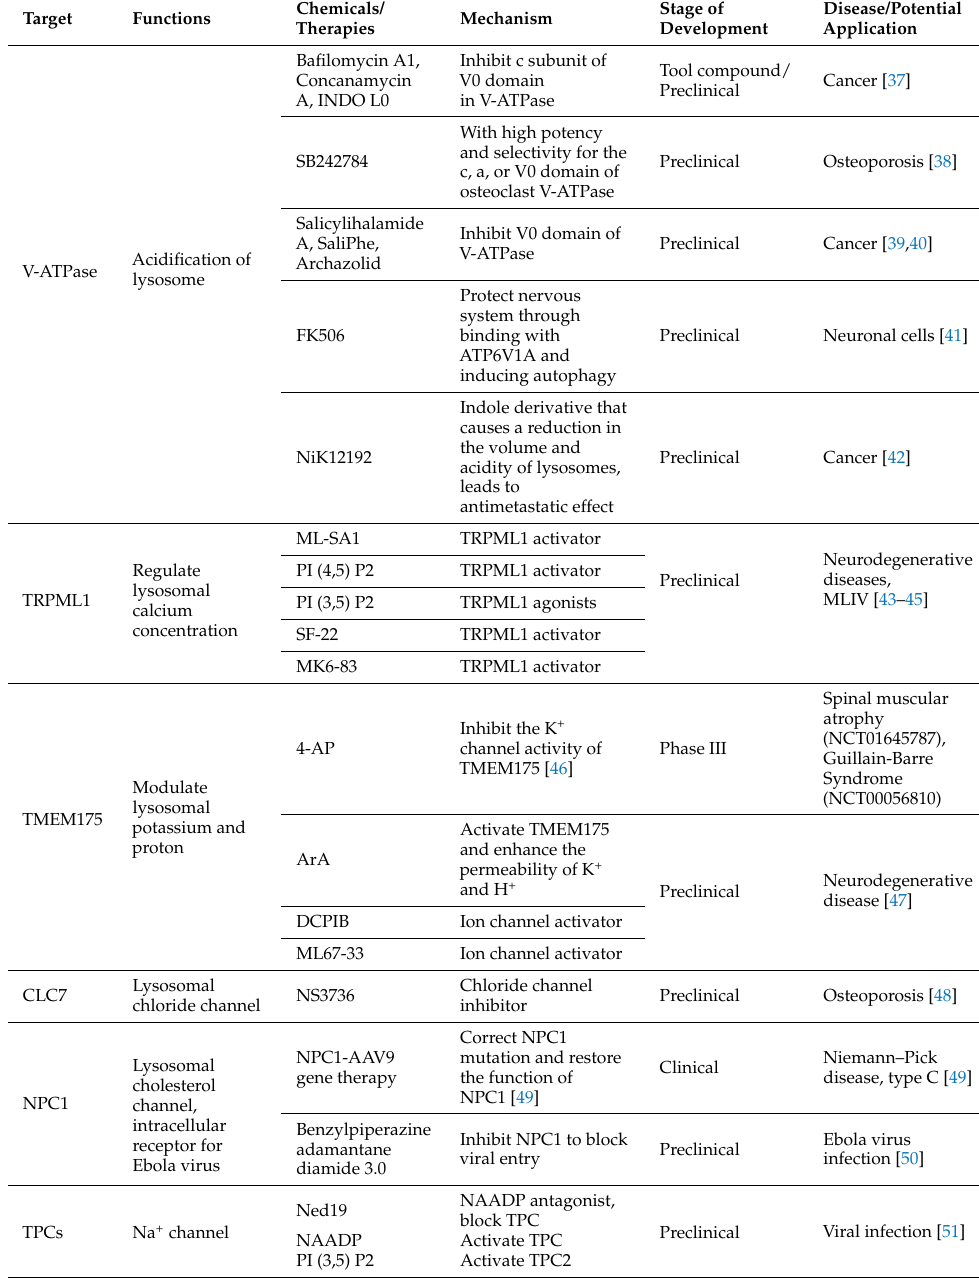
Table 1. Modulators/therapies targeting lysosomal membrane proteins and related preclinical/ clinical